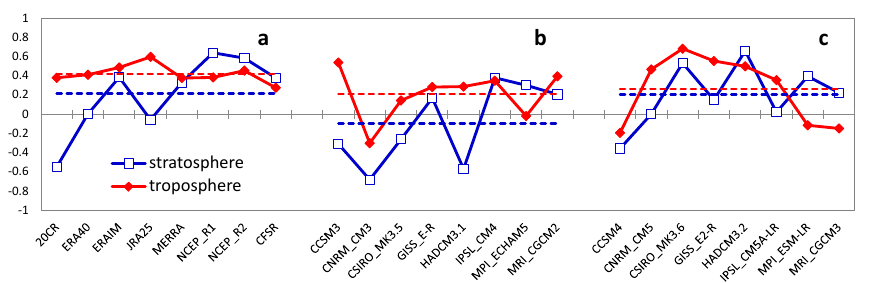
Fig. 3. The spatial correlation of temperature trends between reanalysis, CMIP3, CMIP5 and the radiosonde mean trends from 1979 to 2005. (a) Reanalysis; (b) CMIP3; (c)